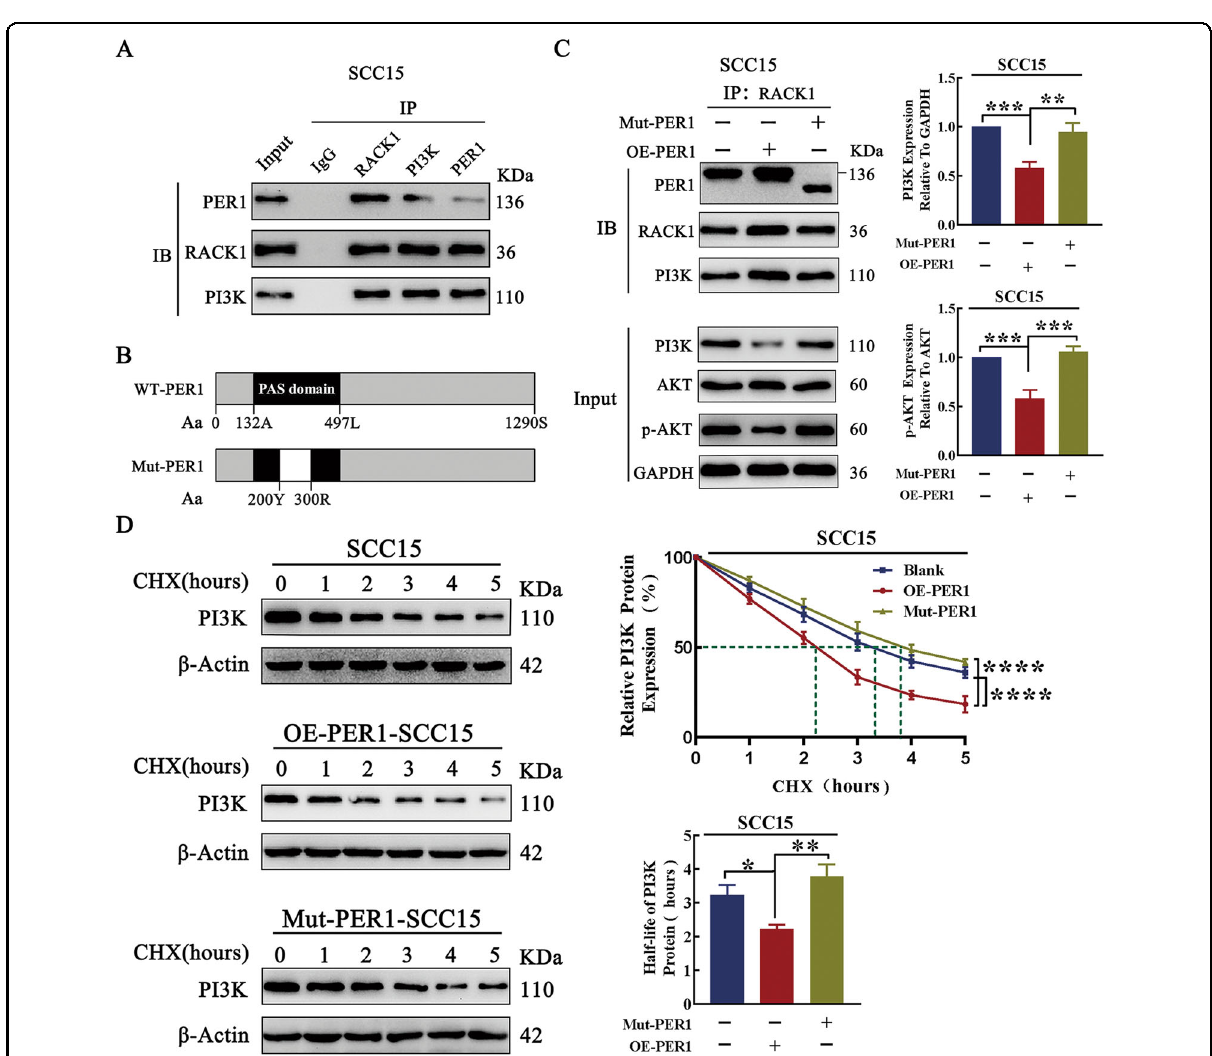
Fig. 6 Regulation of the PI3K/AKT pathway via the PER1/RACK1/PI3K complex. A The Co-IP results showed that PER1 interacted with RACK1 and PI3K to form the PER1/RACK1/PI3K complex. B The amino acid sequences of wild-type and mutant PER1 (the blank box represents the amino acid sequence of the deletion mutant). A stands for alanine, L for leucine, S for serine, Y for tyrosine, and R for arginine. C The Co-IP and western blot results showed that, in OE-PER1-SCC15 cells, the abundance of the PER1/RACK1/PI3K complex was signi fi cantly increased but the intracellular protein levels of total PI3K and p-AKT were signi fi cantly decreased, while in Mut-PER1-SCC15 cells, the increase in the abundance of the PER1/RACK1/PI3K complex and the decreases in the intracellular protein levels of total PI3K and p-AKT were signi fi cantly reversed. D The CHX chase experiment showed that the half-life of the PI3K protein in OE-PER1-SCC15 cells was signi fi cantly decreased, while the decrease in the half-life of the PI3K protein was signi fi cantly reversed in Mut-PER1-SCC15 cells. All data are from three independent experiments. The data are presented as the mean ± SD values ( n ≥ 3). * P < 0.05; ** P < 0.01; *** P < 0.001; **** P <